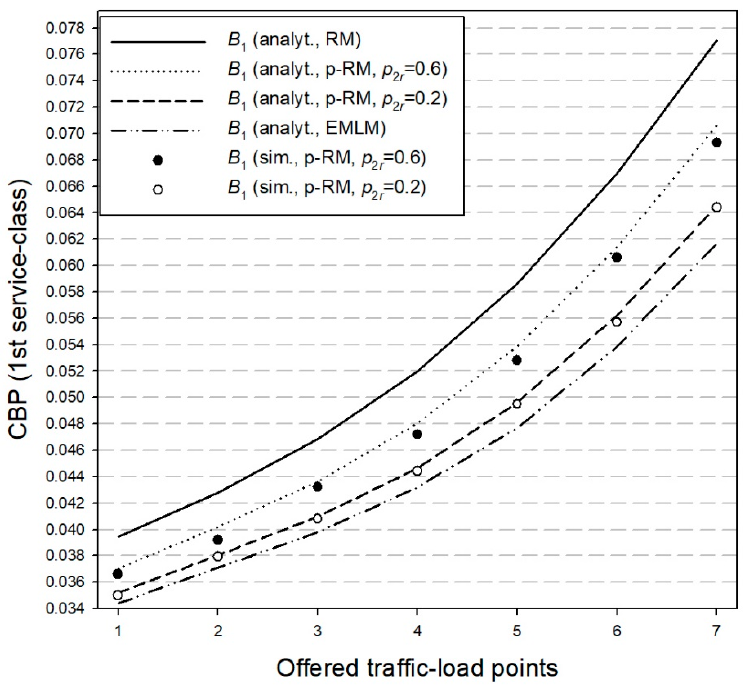
Figure 3. CBP—First service-class (probabilistic retry loss model).